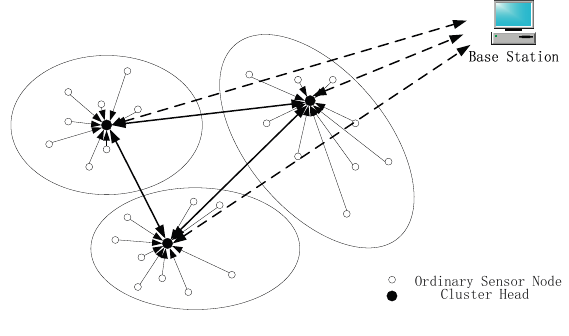
Figure 1. Topology of